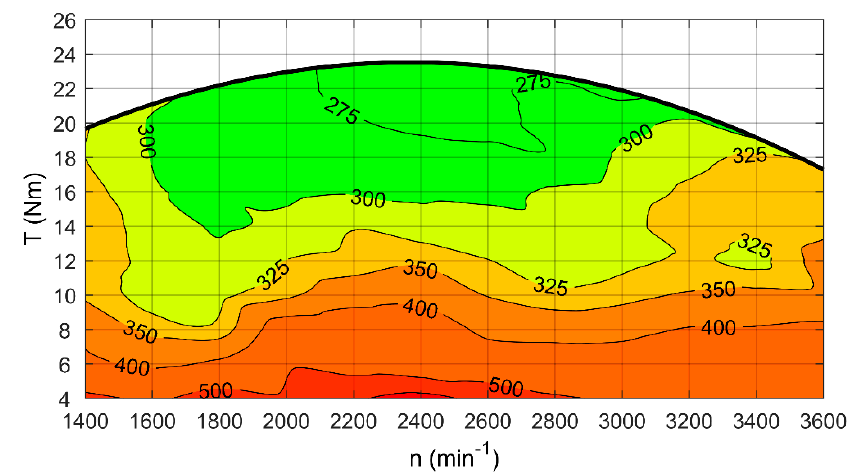
Figure 6. Brake specific fuel consumption (BSFC) (g/kWh) of the range extender supplied with LPG.